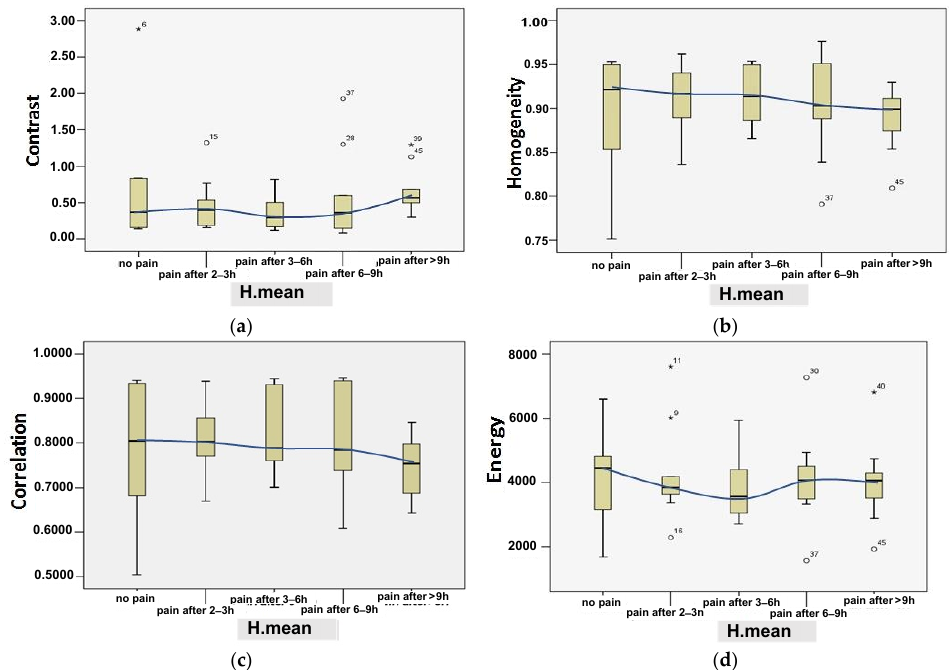
Figure 8. The effect of SM usage examined by time duration (i.e., H.mean) on the contrast ( a ), homogeneity ( b ), correlation ( c ), and energy ( d ). Mild outliers, the values smaller than [Q1 – 1.5(IQR)] or larger than [Q3 + 1.5(IQR)], represented by circles; the extreme outliers, values smaller than [Q1 – 3(IQR)] or larger than [Q3 + 3(IQR)], represented by stars, as shown and detailed in Figure